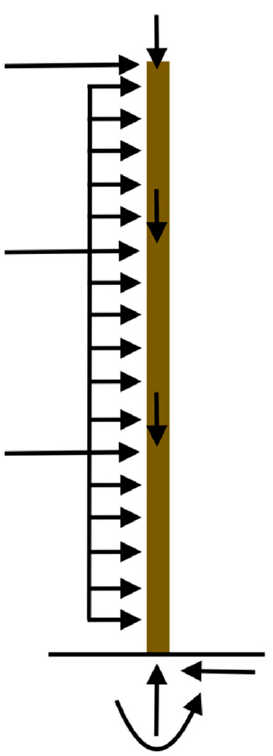
Figure A9. The 6 × 6 Free-Body Diagram. The shear force diagram is seen in Figure A10.